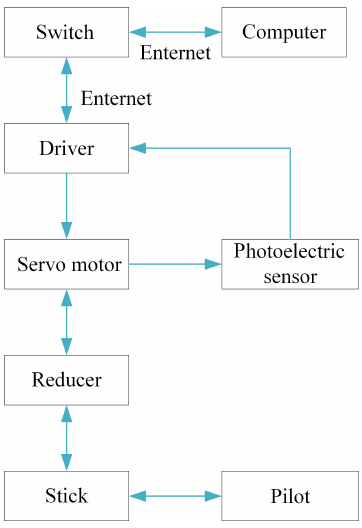
Figure 3. Hardware system composition of haptic interface.